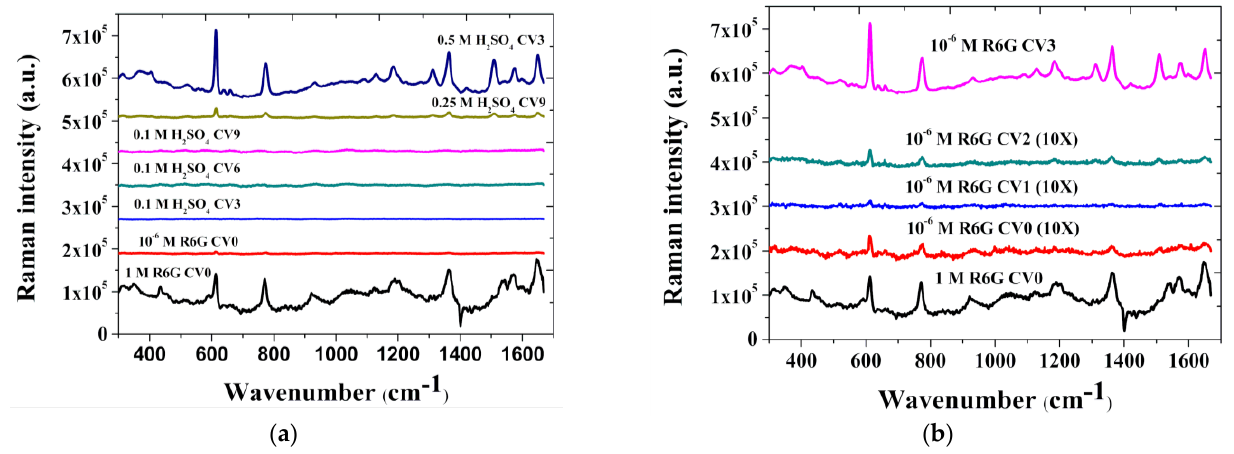
Figure 3. The intensity of the 10 −6 M Rhodamine 6G (R6G) surface-enhanced Raman scattering (SERS) signal on the nanostructures (NPS-AuFON) under different concentrations of electrolytes and CVs—( a ) CV 3 to CV 9; ( b ) CV 0 to CV 3.